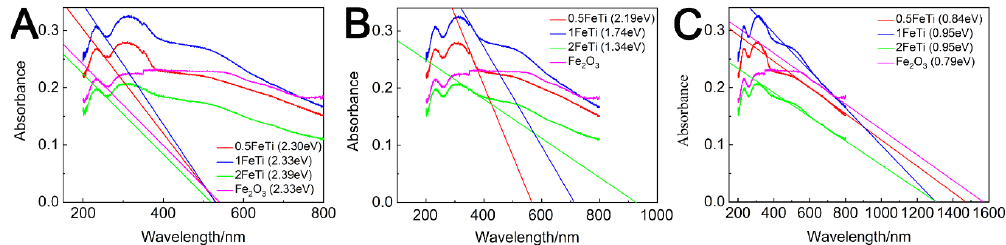
Figure 5. UV−vis absorption spectra and the bandgap correlations for 0.5FeTi, 1FeTi , 2FeTi, and Fe 2 O 3 Figure 5. UV − vis absorption spectra and the bandgap correlations for 0.5FeTi, 1FeTi, 2FeTi, and Fe 2 O 3 in the range of ( A ) 240 – 255 nm; ( B ) 354 – 380 nm; ( C ) 590 – 720 nm. in the range of ( A ) 240–255 nm; ( B ) 354–380 nm; ( C ) 590–720 nm.